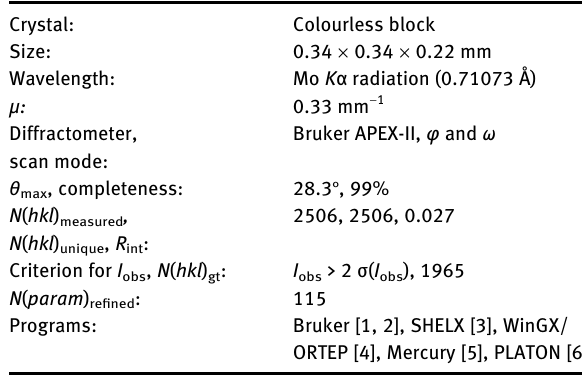
Table  : Data collection and handling.